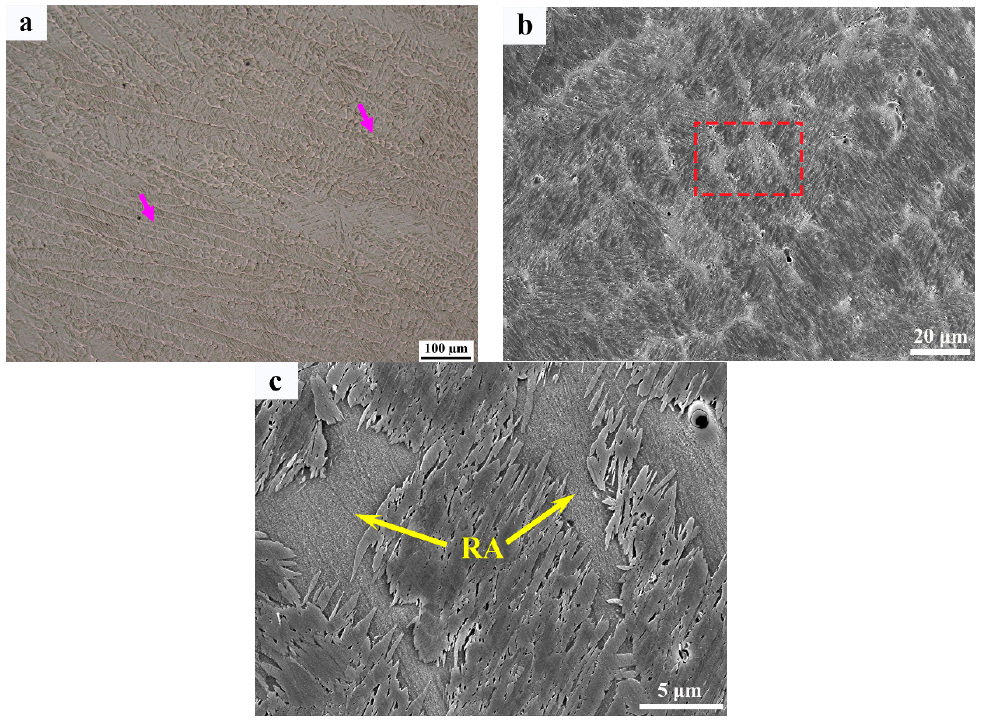
Figure 5. Phase constituents in weld and base metal; ( a ) Schaeffler diagram; and ( b ) XRD patterns .